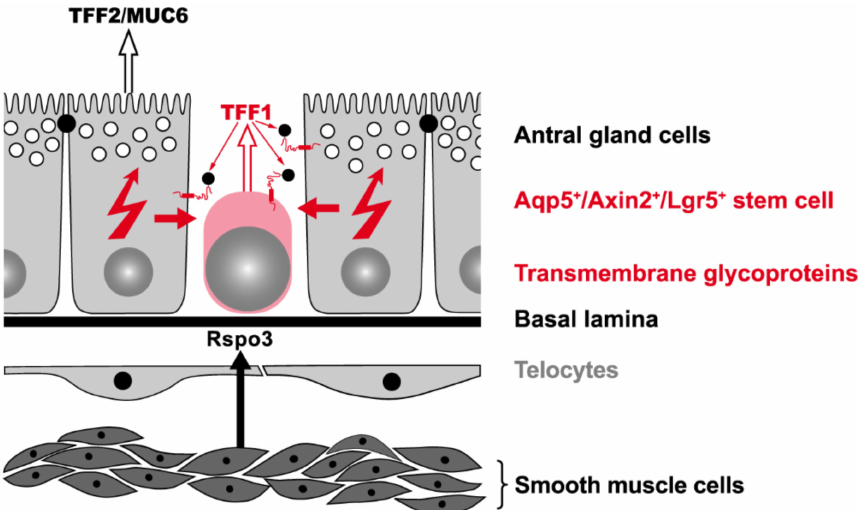
Figure 5. Schematic representation of an Aqp5 + /Axin2 + /Lgr5 + stem cell and its niche at the base of a murine antral unit and hypothetical model on the role of Tff1 for regulating antral gland differentiation and proliferation. Neighboring AGCs characteristically express A4gnt and secrete Tff2 and Muc6. Rspo3 from smooth muscle cells beneath the gland base induces secretion of Tff1 from the Lgr5 + stem cell. Depicted are also α GlcNAc glycosylated transmembrane proteins at the basolateral side of AGCs and on the Lgr5 + stem cell, respectively. Tff1 can bind as a lectin to these transmembrane glycoproteins triggering signaling events (Lectin-triggered Receptor Blocking Hypothesis